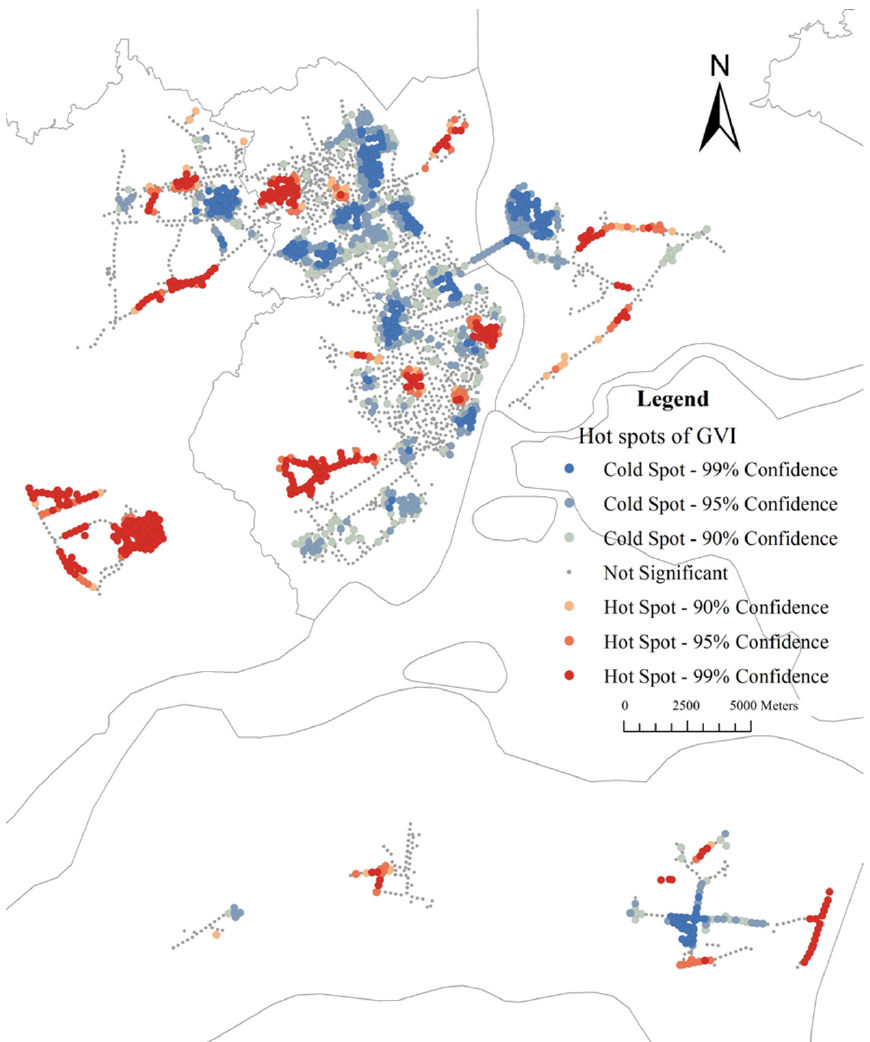
Figure 8. Distribution map of GVI hotspots.